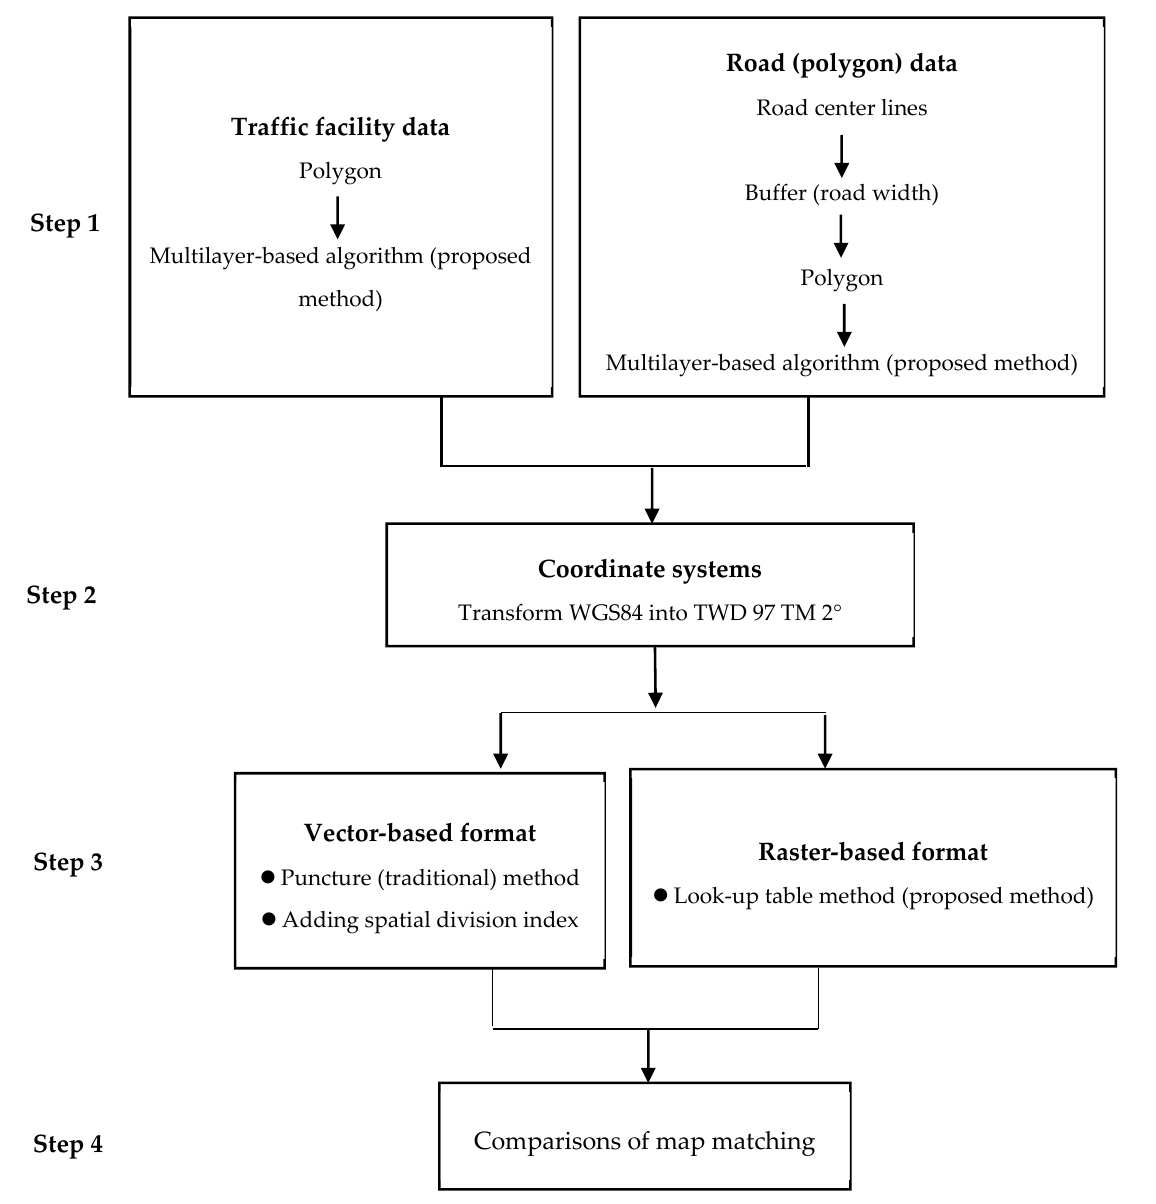
Figure 1. Flowchart for the multilayer-based map matching